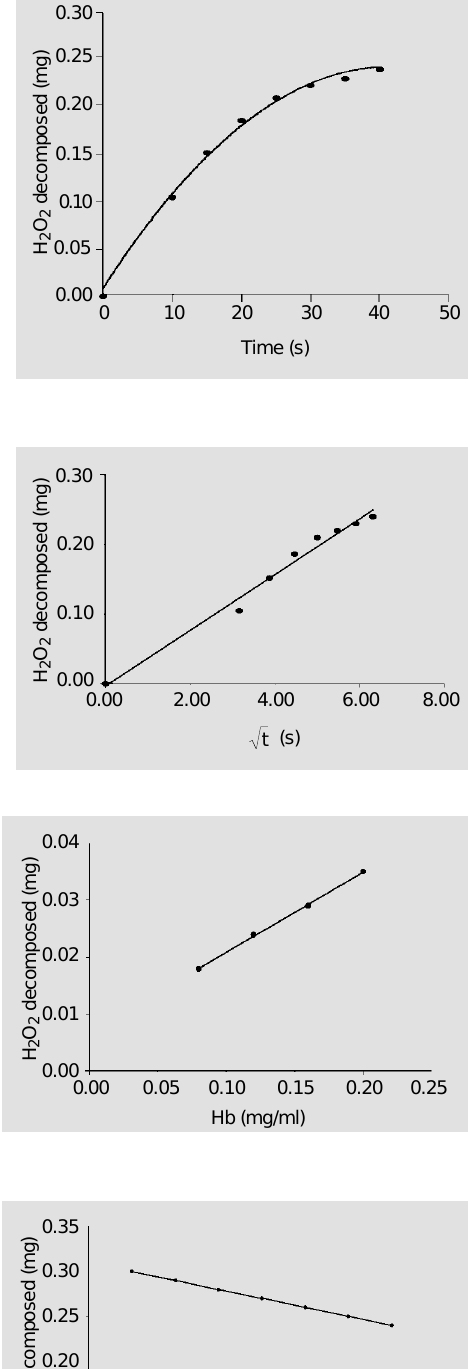
Figure 5 - Decrease in catalase activity as a function of time. Blood was diluted in distilled water at room temperature (range 20 to 24 o C). The equation of the straight line is y = -0.01x + 0.31. R 2 = 1.0. The inactivation rate was